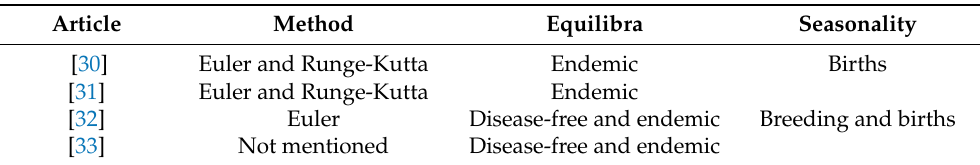
Table 1. Iteration method, equilibra points and seasonalities studied through numerical simulations in